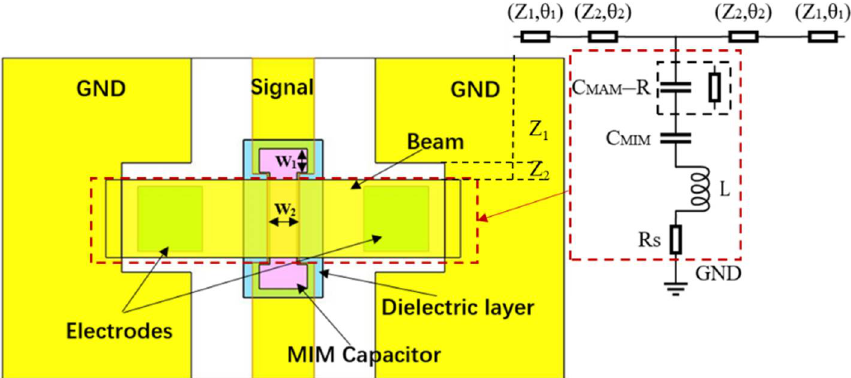
Figure 3. The metal-insulator-metal (MIM) capacitor switch radio frequency (RF) model, adapted with permission from ref. [16]. Copyright 2020, Springer